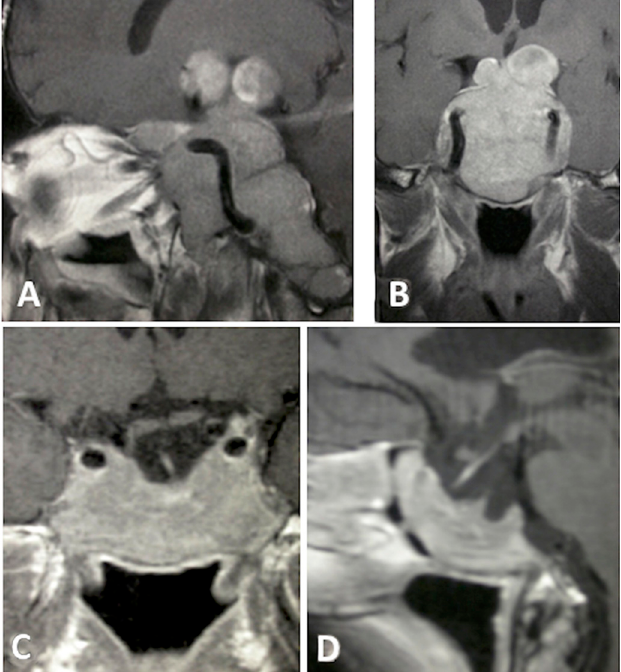
Figure 2. T1- weighted contrast-enhanced coronal MR images. Preoperative view ( A ) showing a giant pituitary macroadenoma, Knosp grade 3. ( B ) Three-month postoperative view showing NTR with a small tumor residue in the medial left cavernous sinus (white asterisk).